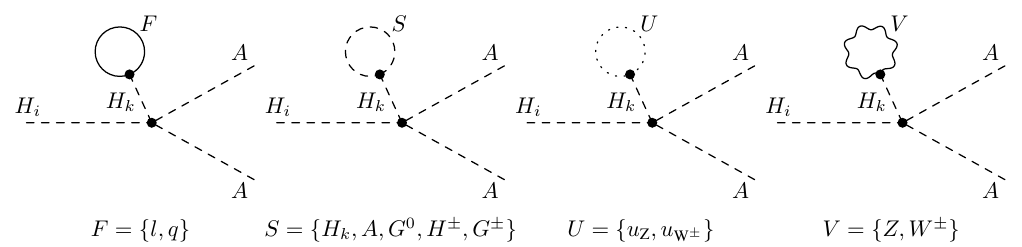
Figure 9 . Tadpole contributions to the vertex diagrams to be included in the decay H i ! AA in the alternative tadpole